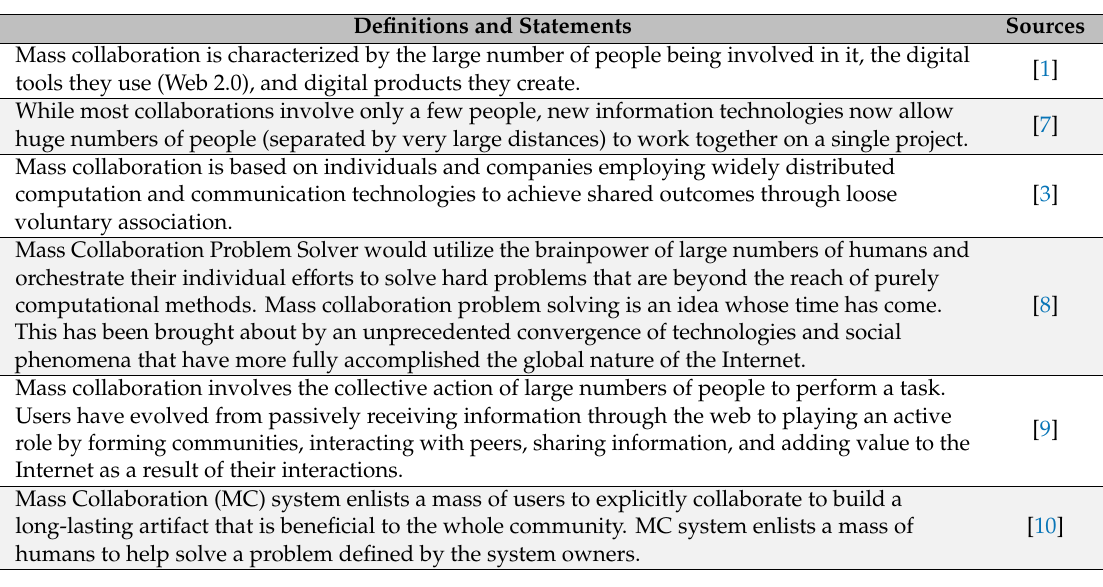
Table 1. Some partial definitions of mass collaboration.